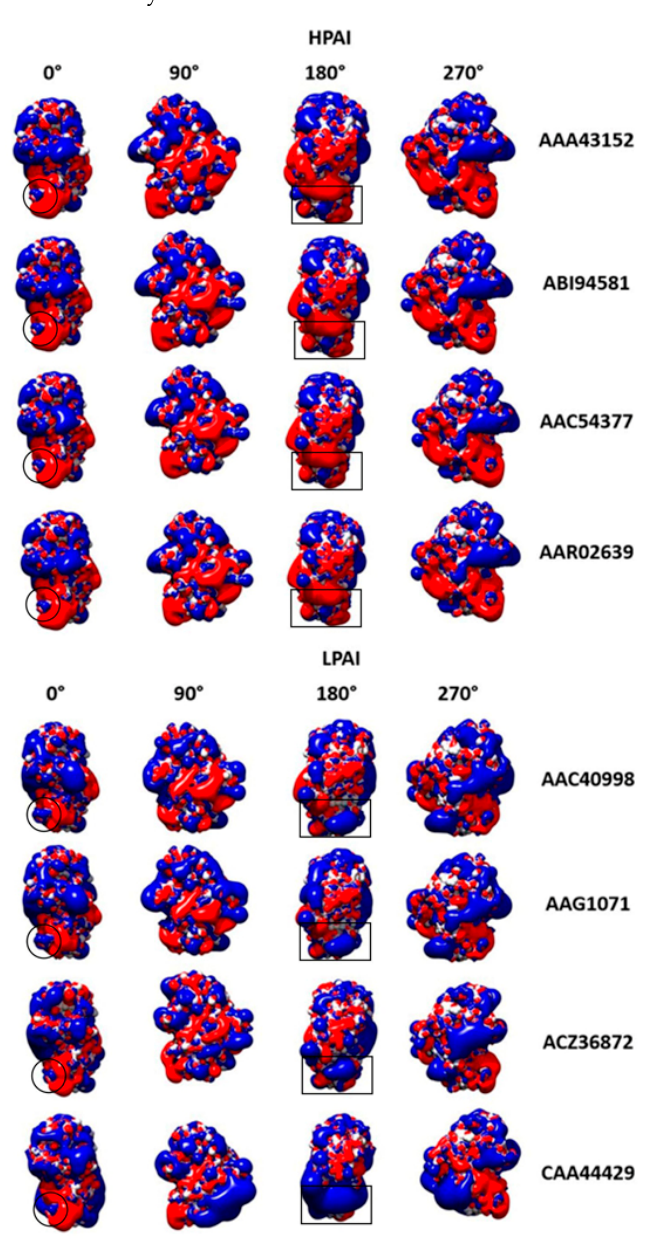
Figure 3. Surface charge distribution of the HA RBDs from four representative HPAI and four LPAI H7N7 strains. Positive, blue; negative, red; neutral, white. Four 90° stepwise orientations are shown. Open circle, VED subregion; open rectangle, region where K122E, K182N mutations result in nega- tivization/depositivization.